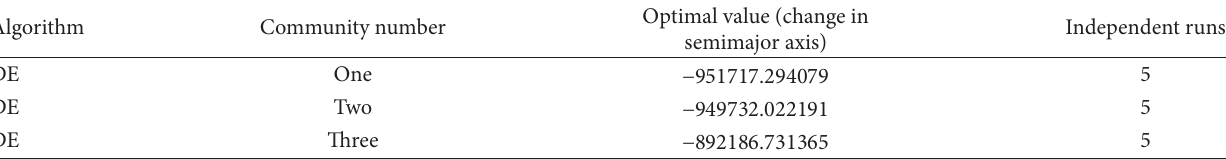
Table 12: Optimal value of each community.